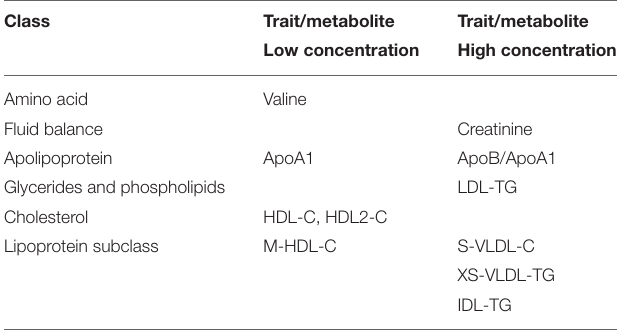
TABLE 2 | Summary table of differential plasma metabolites and their concentrations.